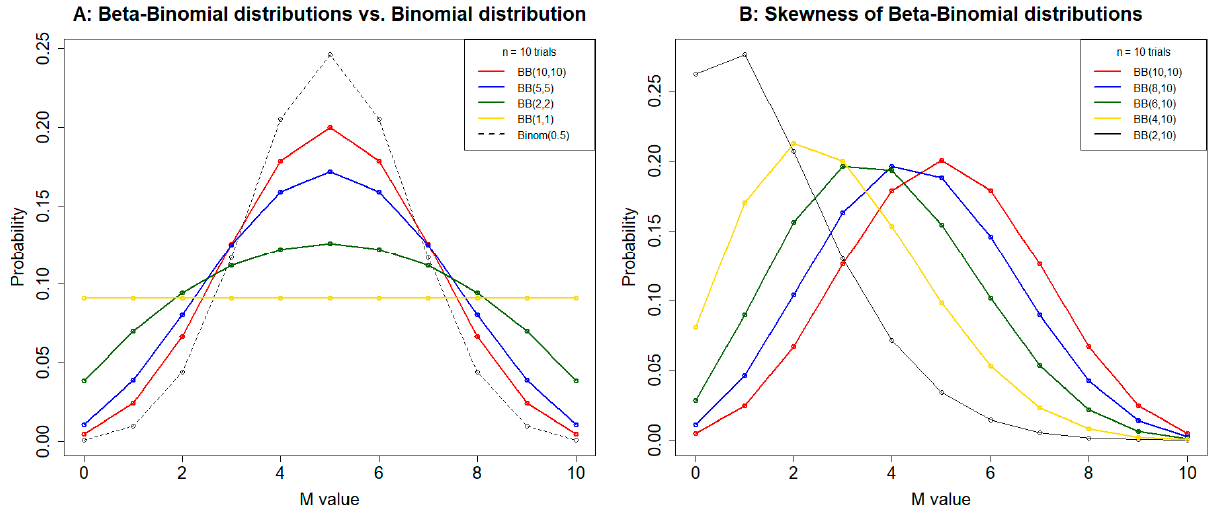
Figure 1. Comparisons of Beta-Binomial distributions.